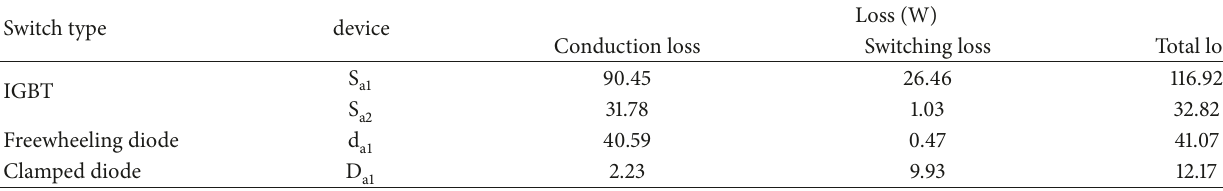
Table 1: The loss of each device in hybrid T-type inverter.